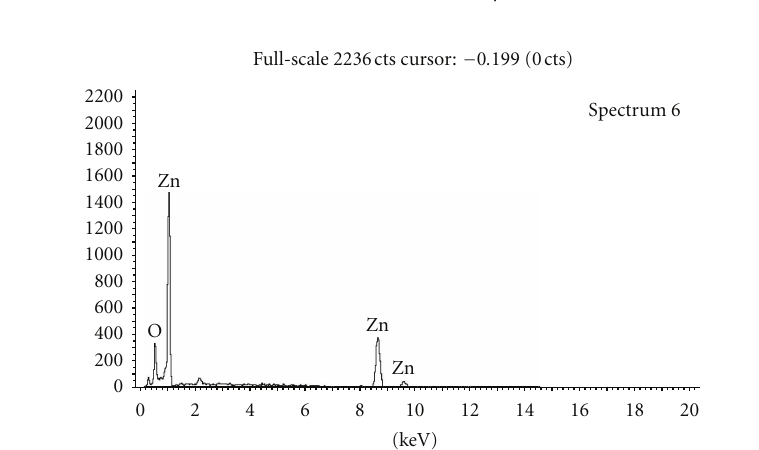
Figure 4: EDX spectrum of ZnO